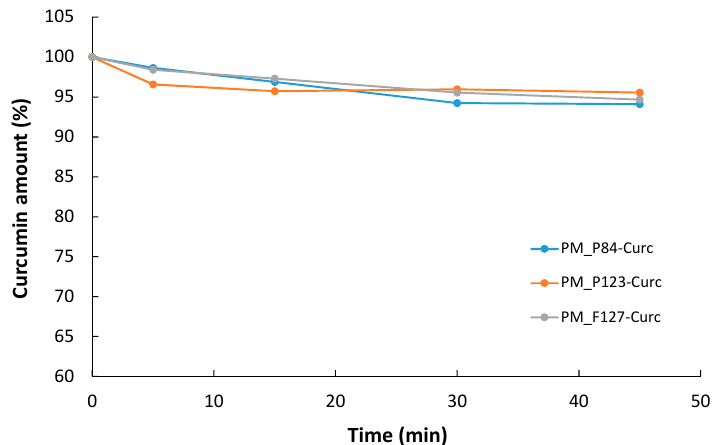
Figure 6. Degradation of CURC encapsulated in Pluronic micelles under visible irradiation (470 nm).